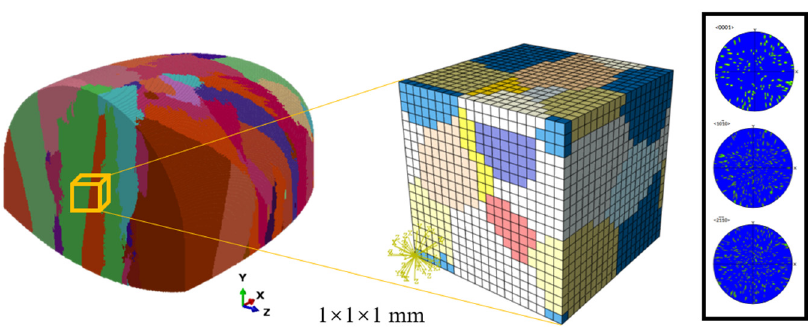
Figure 18. The polycrystalline RVE mesh model for FEA. Table 5. α transverse isotropic elastic tensor parameter of the phase